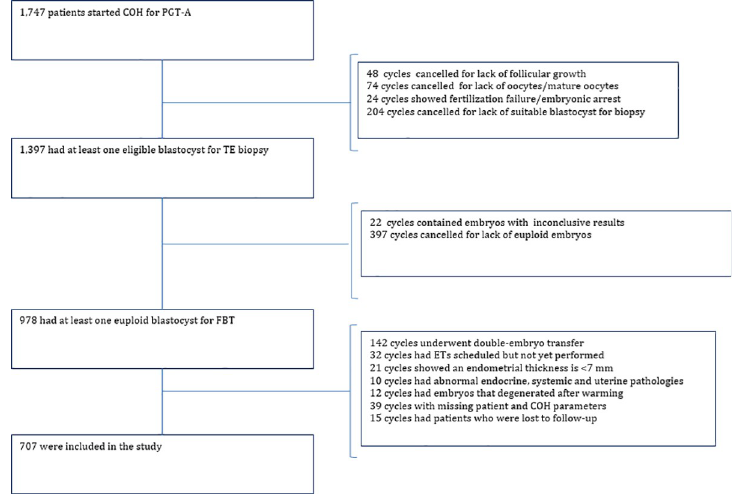
Fig 1. Flowchart of cycles included in the